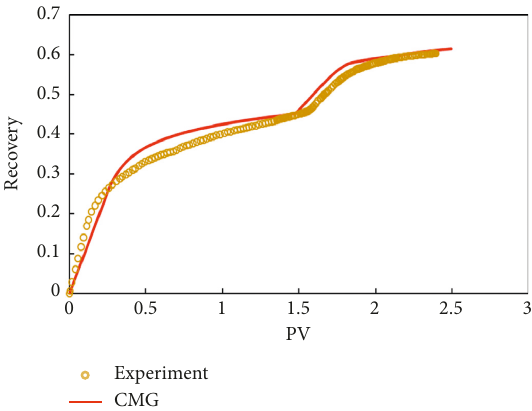
Figure 27: History matching result of